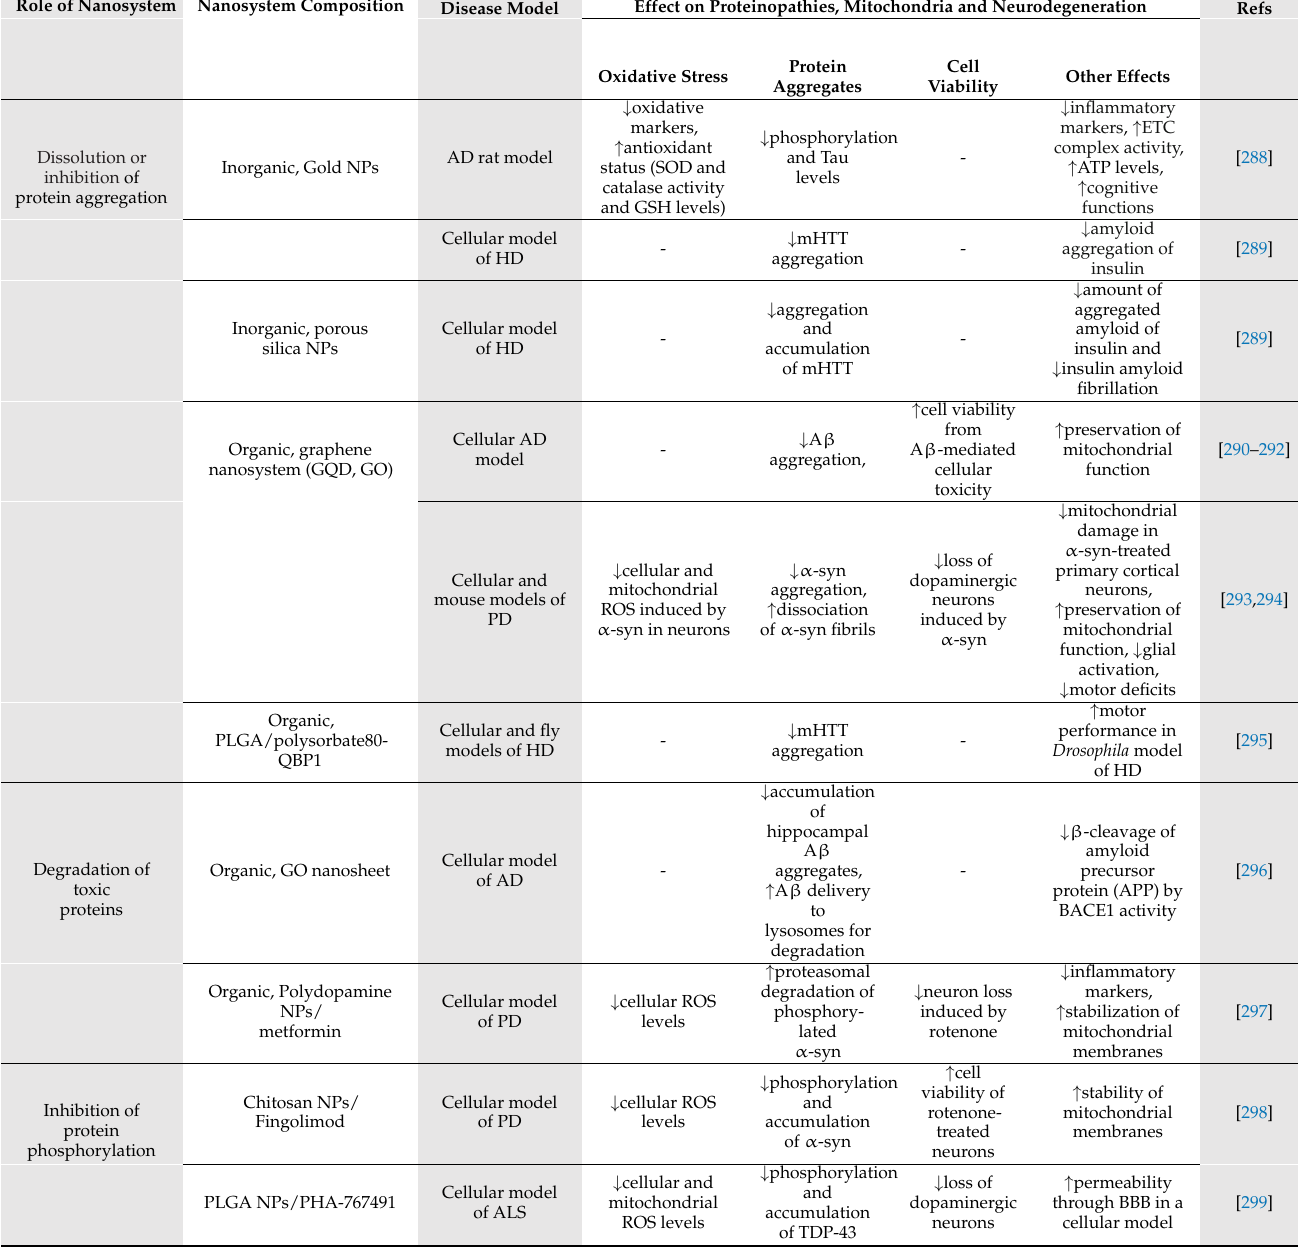
Table 5. Nanosystems to reduce the biological impact of proteinopathies in models of neurodegenerative diseases. Role of Nanosystem Nanosystem